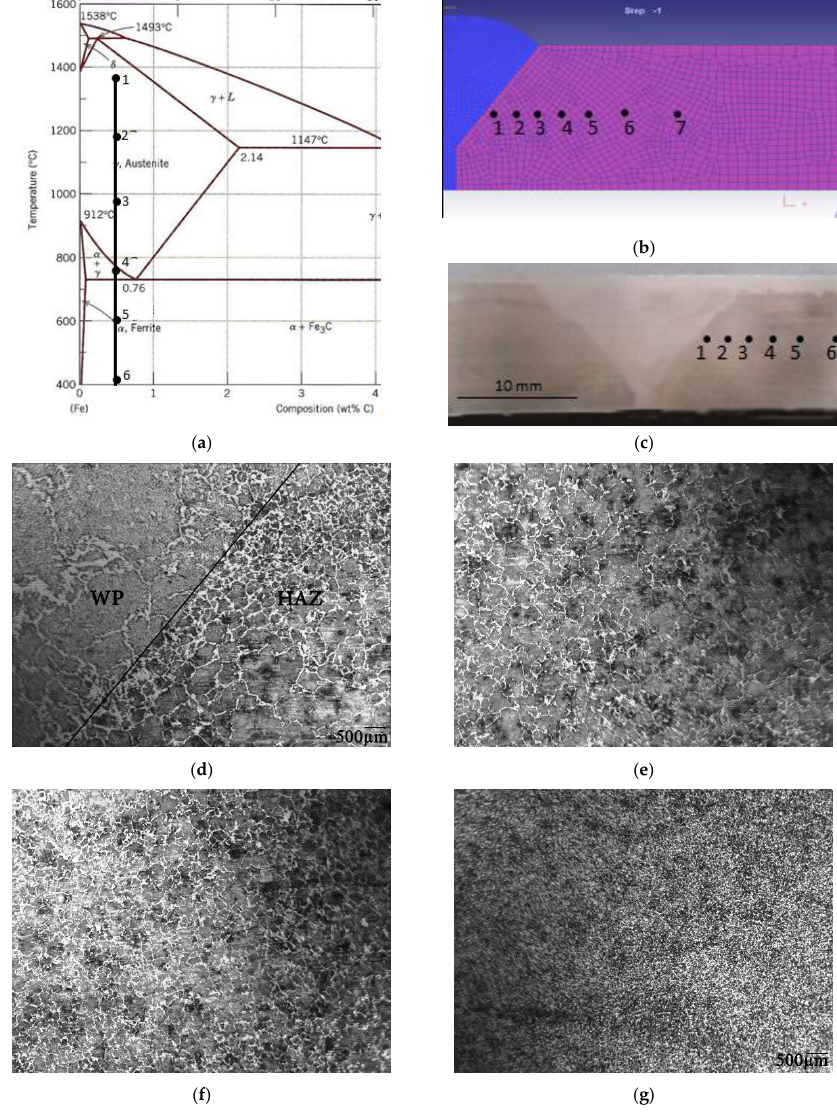
Figure 9. ( a ) Fe-C diagram ( b ) Finite element model ( c ) macrograph, and microstructures around ( d ) point 1 ( e ) point 2 ( f ) point 3 ( g ) point 4 on the transverse section of the welded AISI 1045 steel.